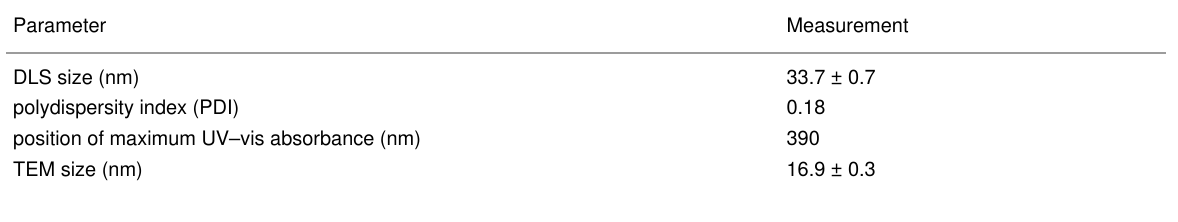
Table 1: NP characterization results. Characterization of PVP-AgNPs in UHPW. DLS and TEM sizes are reported as mean ± standard